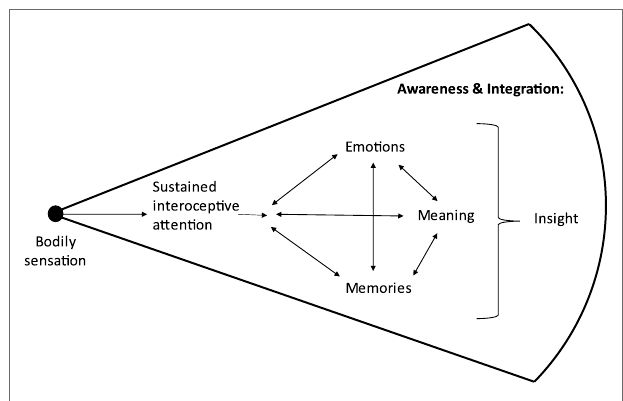
FIGURE 1 | Experiential space and somatic reappraisal: components that contribute to awareness and integration.